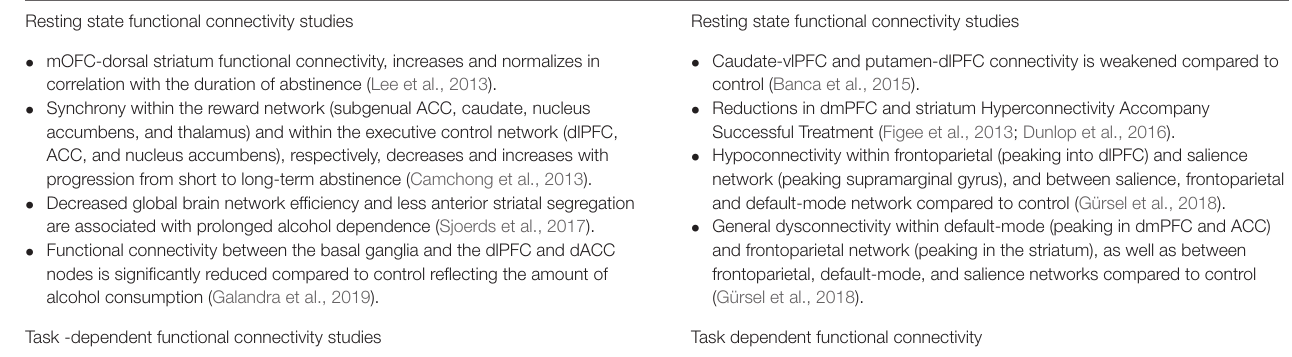
TABLE 1 | Fronto-striatal functional connectivity and cognitive control in AUD and OCD. AUD OCD Resting state functional connectivity